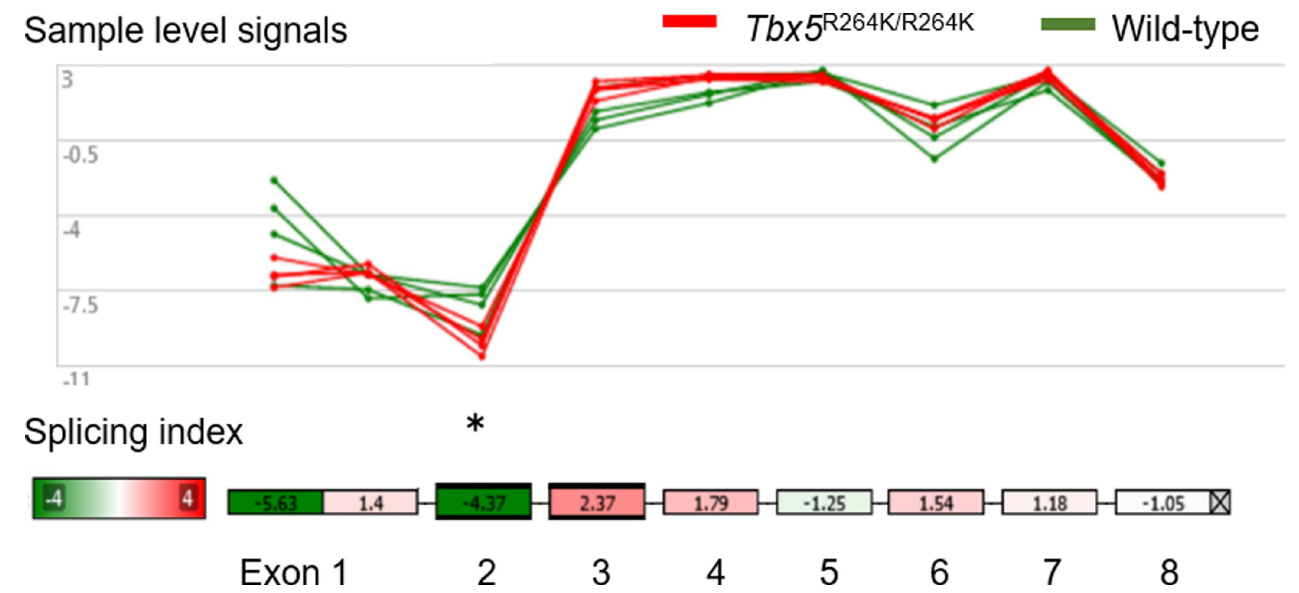
Fig 3. Exon splicing variant analysis in Acta1 by Transcriptome Analysis Console software. Transcriptome Analysis Console software shows the sample level signals and schema of Acta1 for each exon from 1 to 8 of each 4 wild-type mice (green) and Tbx5 R264K/R264K mice (red) in the young adult group. Of these, the only significant variation derived from sample level signals was a 4.37-fold decrease in exon 2 in the Tbx5 R264K/R264K mice group. P value � < 0.05, versus wild-type.